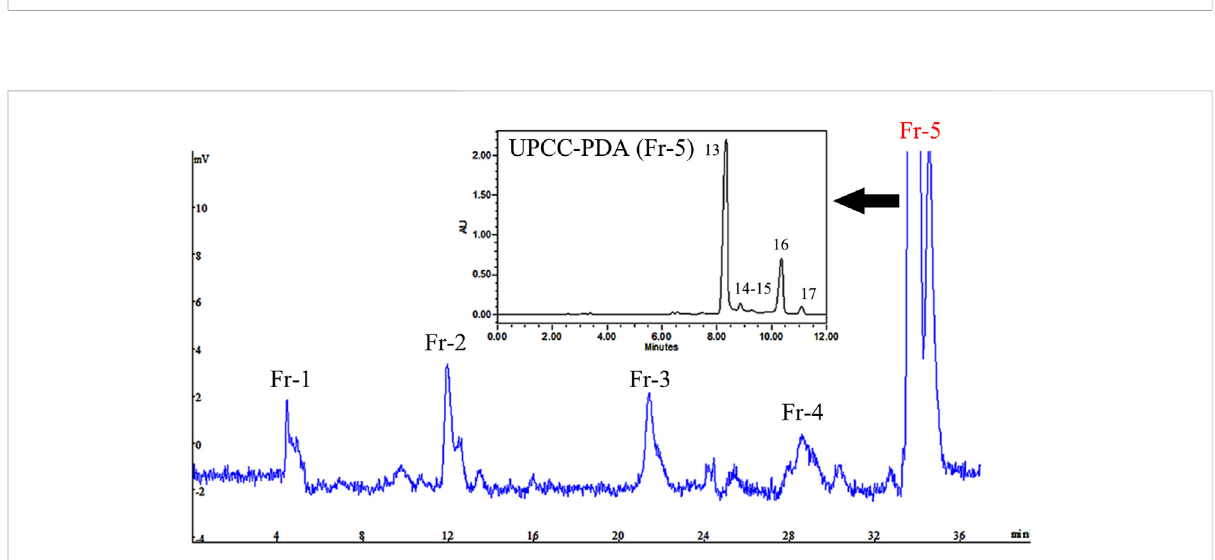
MS E spectra of Lycium carotenoids. (A) Zeaxanthin; (B) zeaxanthin dipalmitate.